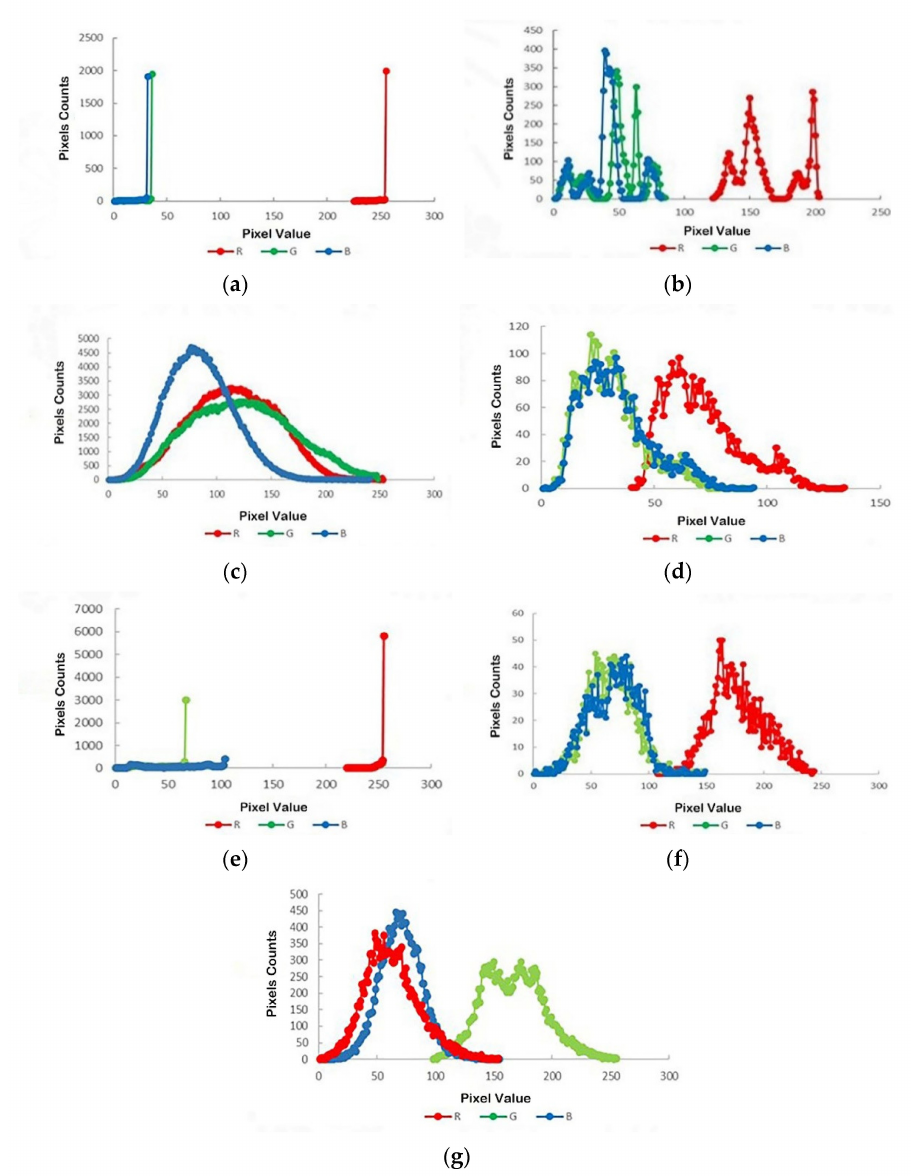
Figure 4. Examples of RGB pixel distribution map: ( a ) RGB band pixel value distribution map on cement surface; ( b ) RGB band pixel value distribution map of water body; ( c ) RGB band pixel value distribution map of damaged forest; ( d ) RGB band pixel value distribution map of burnt